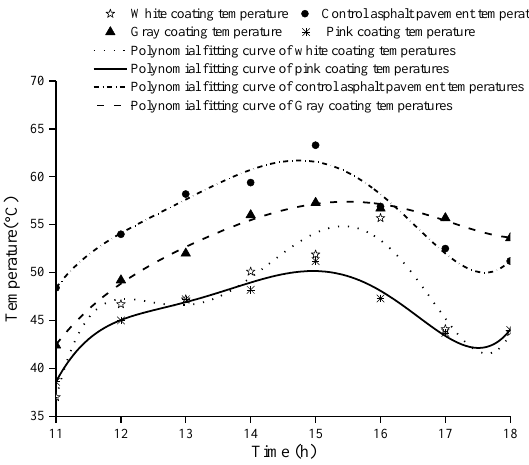
Figure 9. Surface temperature of different coating pavement.